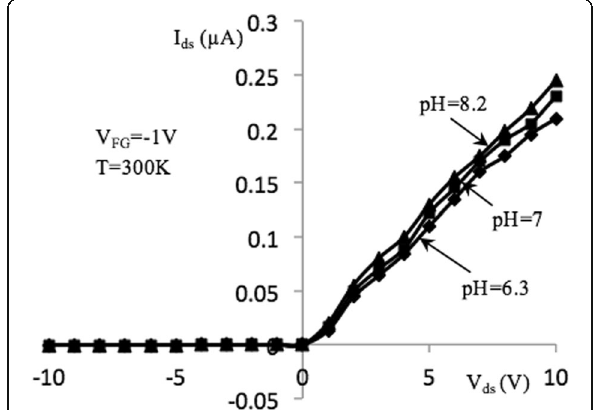
Fig. 5 I – V characteristics of NW FET, measured in different pH solutions ( V FG = − 1 V). Output current – voltage characteristics of NW FET with length, l =10 μ m, measured in the dark and pH concentrations: 6.3, 7, 8.2 at T =300 K, V BG = − 5 V, and V FG = − 1 V